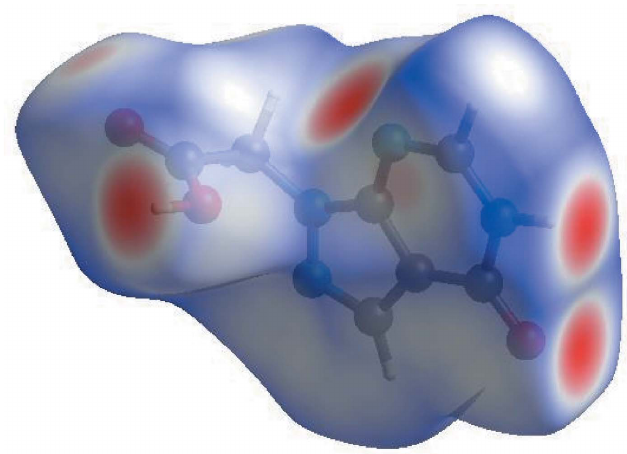
Figure 4 View of the three-dimensional Hirshfeld surface of the title compound, plotted over d norm in the range (cid:4) 0.6986 to 1.3450